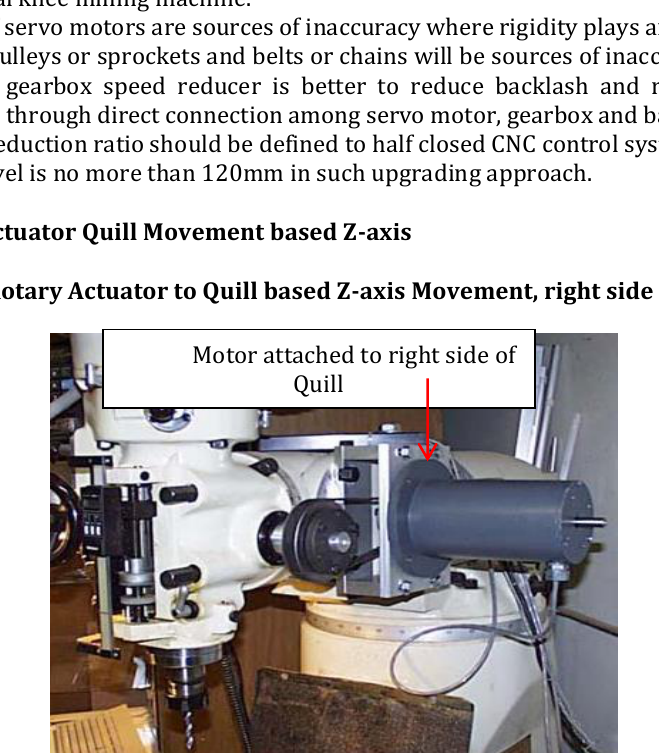
Source : Mumford Micro Systems (n.d.).